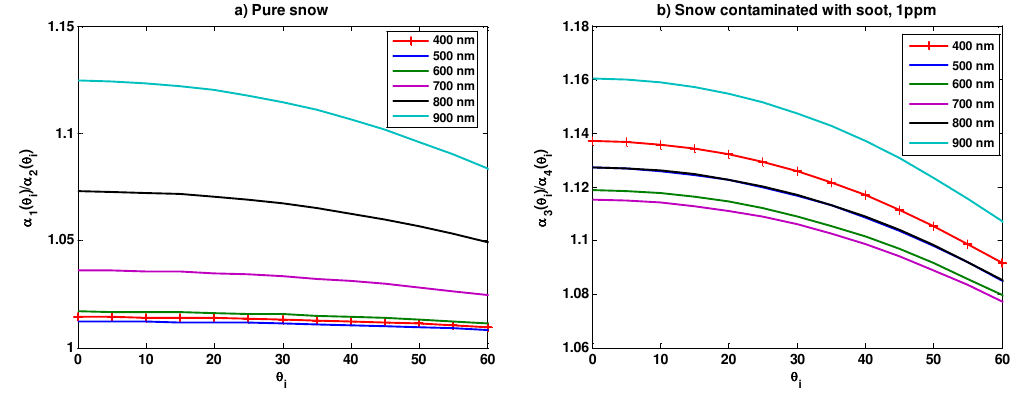
= 150m 2 kg − 1 ) Fig. 3. Ratio α( SSA , for six wavelentghs and as a function of the incident zenith angle, θ i . (a) Pure snow; (b) snow contaminated α( SSA = 30m 2 kg − 1 ) with soot